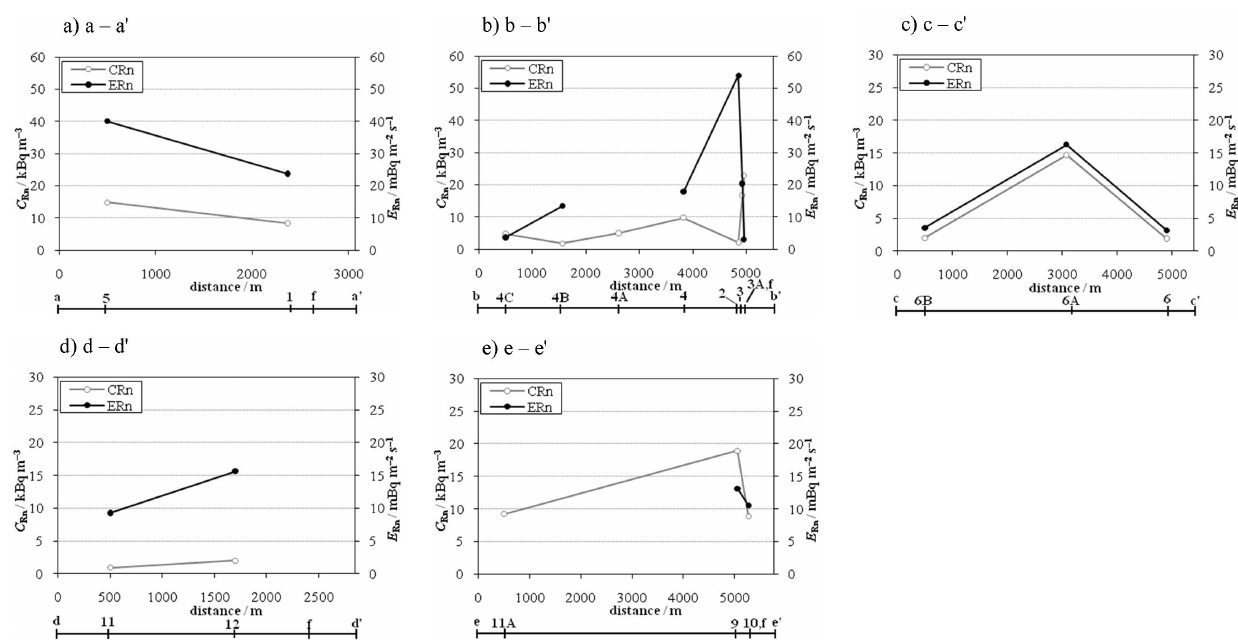
Fig. 6. Radon activity concentrations in soil gas ( C Rn ) and radon exhalation rate ( E Rn ) at profile (f – fault): (a) a–a’, (b) b–b’, (c) c–c’, (d) d-d’, and (e) e–e’.